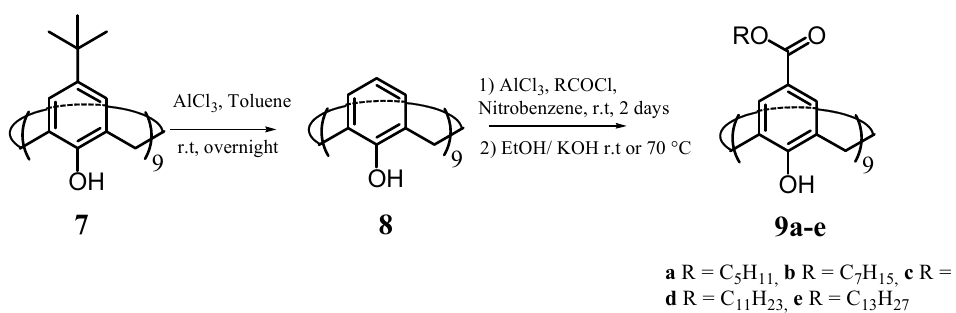
Figure 16. Synthetic route to the amphiphilic para -acyl-calix[9]arenes, 9a – e